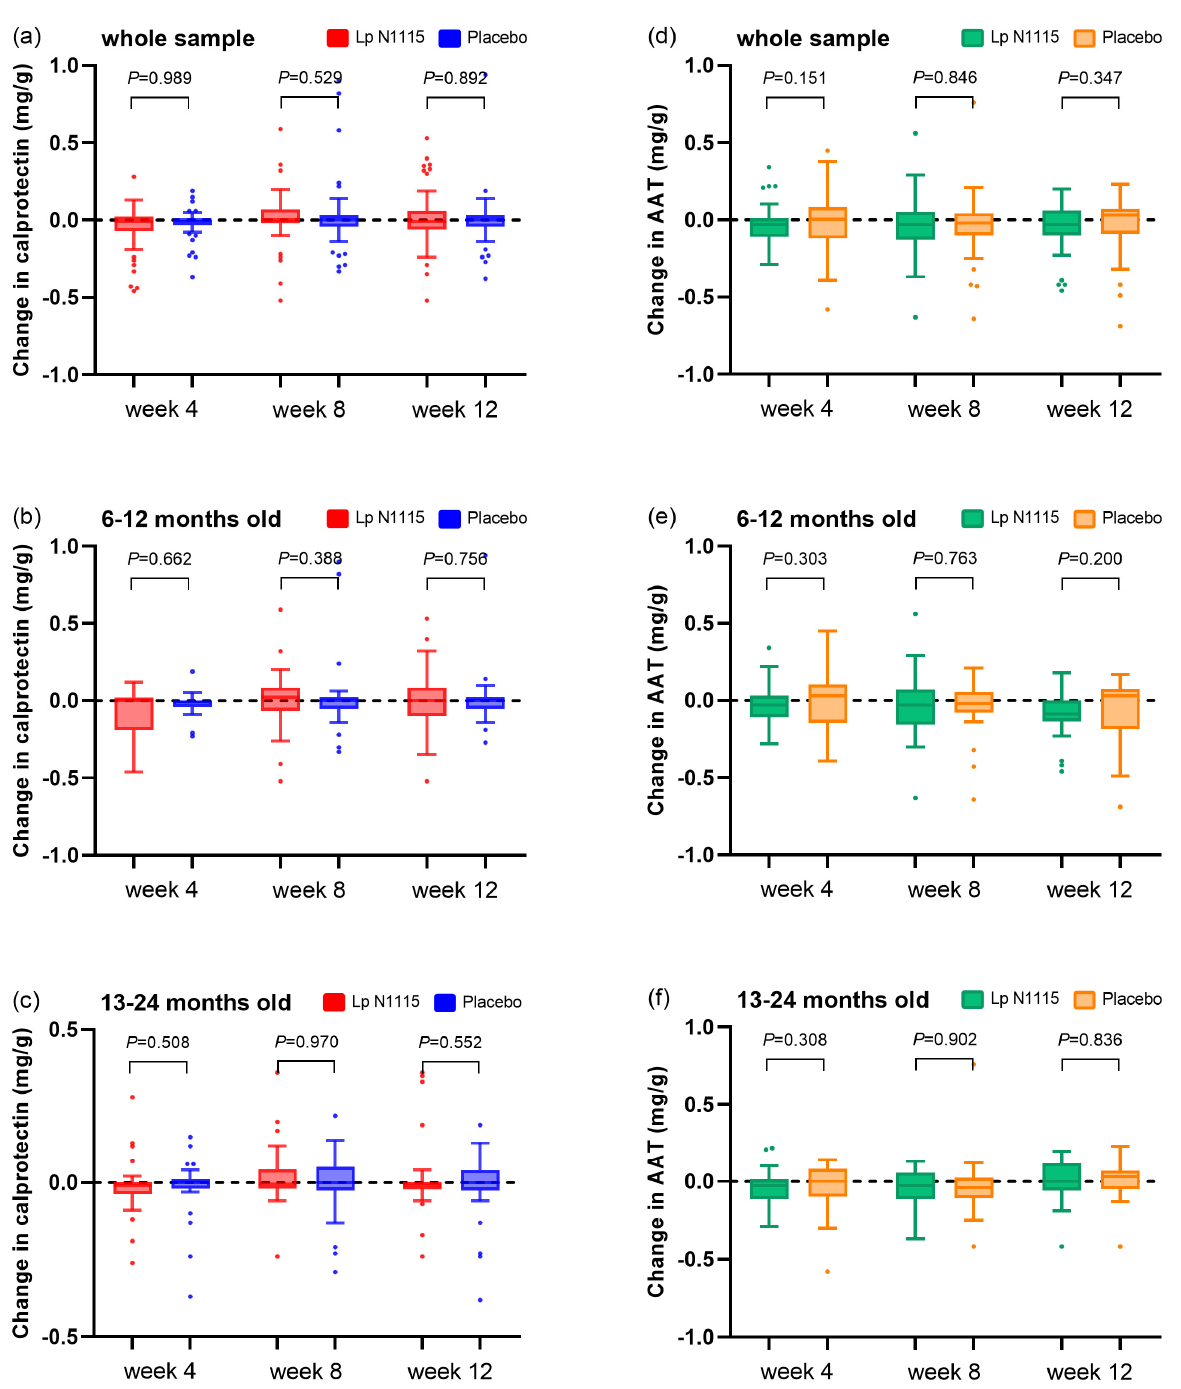
Figure 5. Changes in FC and AAT compared with baseline. ( a ) FC changes of all participants; ( b ) FC changes of 6–12-month-old sub-group; ( c ) FC changes of 13–24-month-old subgroup; ( d ) AAT changes of all participants; ( e ) AAT changes of 6–12-month-old sub-group; ( f ) AAT changes of 13–24-month-old subgroup